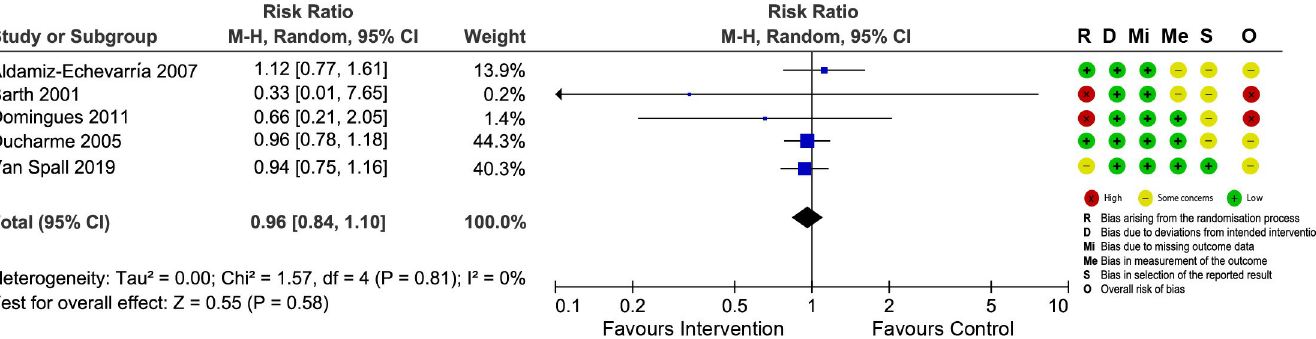
PLOS ONE | https://doi.org/10.1371/journal.pone.0261300 December16,